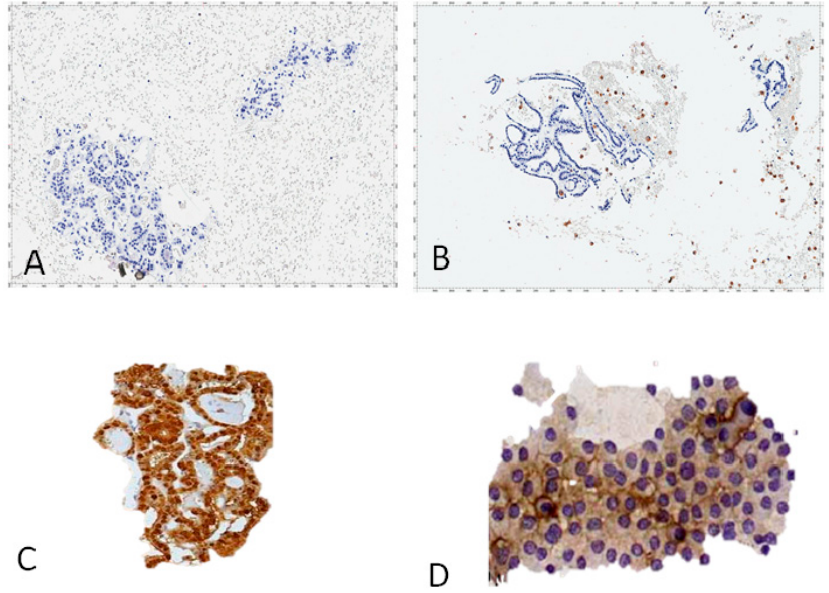
Figure 2. Cellblocks’ preparations from thyroid FNA cytology stained with an HRP-conjugated mAb